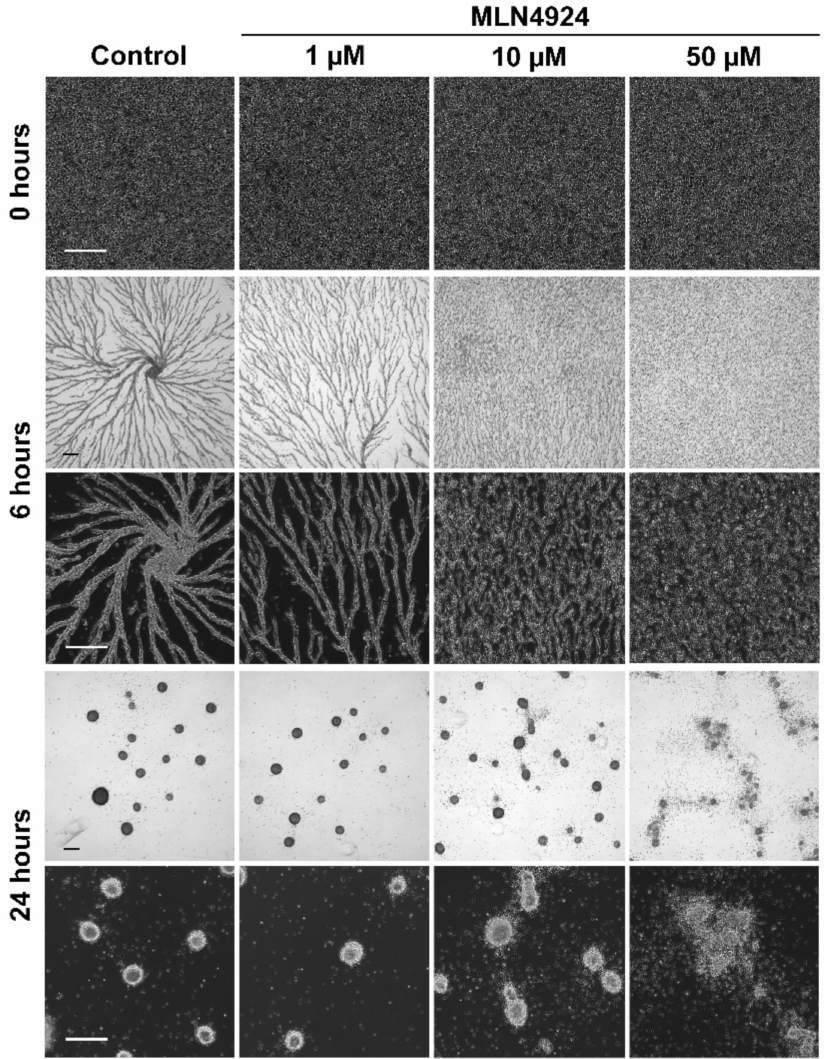
Figure 5. Effect of MLN4924 on aggregation. Cells were starved in KK2 buffer in the presence and absence of MLN4924 (1 µ M, 10 µ M, 50 µ M, control: dimethyl sulfoxide). Cells were imaged at the indicated times. Scale bar = 250 µ m. Images are representative of four independent